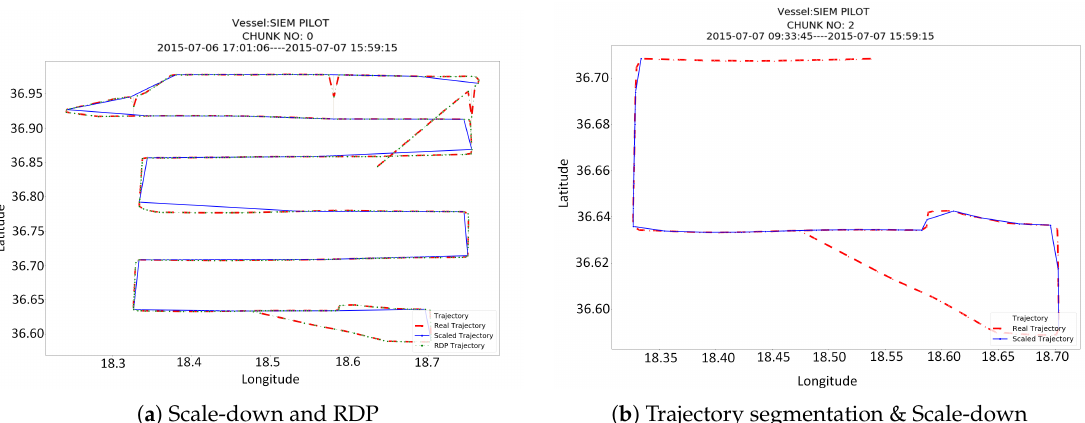
Figure 6. An example of a real trajectory and its pre-processing, using the Scaled down, RDP and trajectory segmentation